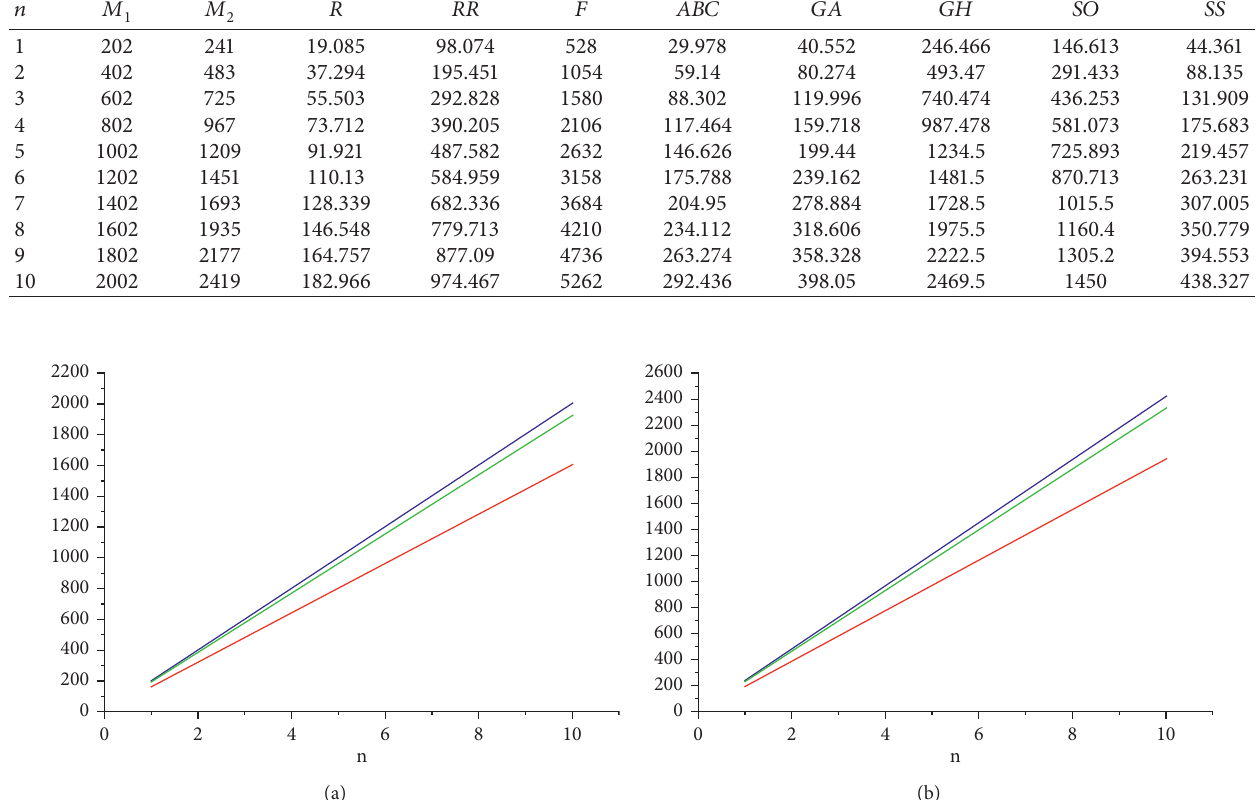
Figure 6: Comparison of Zagreb indices of guar gum, HPG and CMG, and CMHPG. (a) M green, and M (CMHPG) in blue; (b) M 1